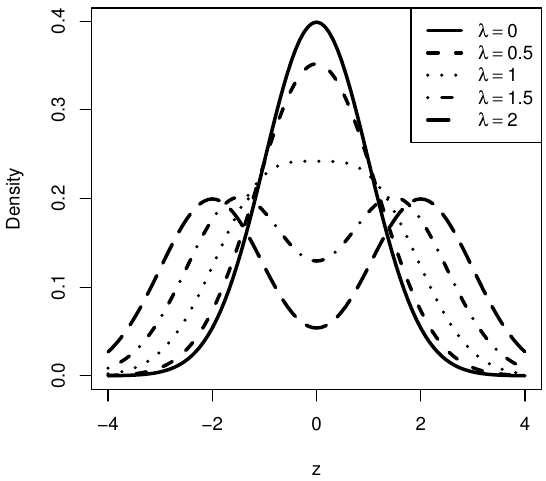
Figure 1. Plot of density function of the TN for different values of λ